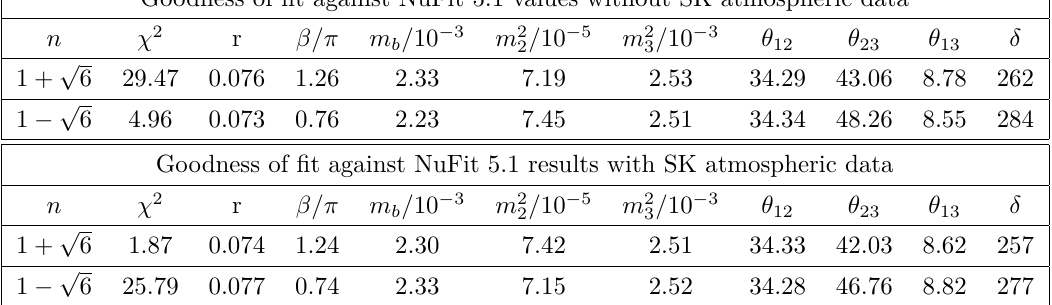
√ −√ 6 and n = 1 6 . Note that from eq. (2.14) and m 2 are given in eV 2 2 3